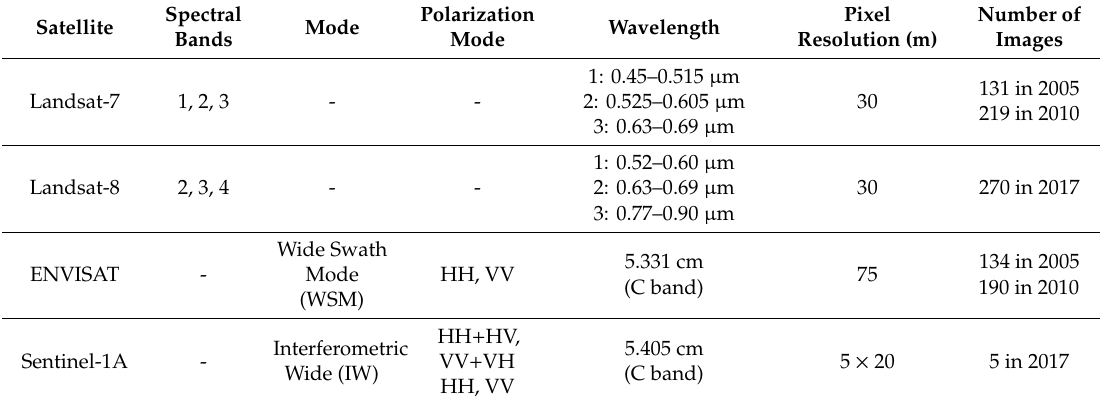
Table 1. Characteristics of the Optical and synthetic aperture radar (SAR)